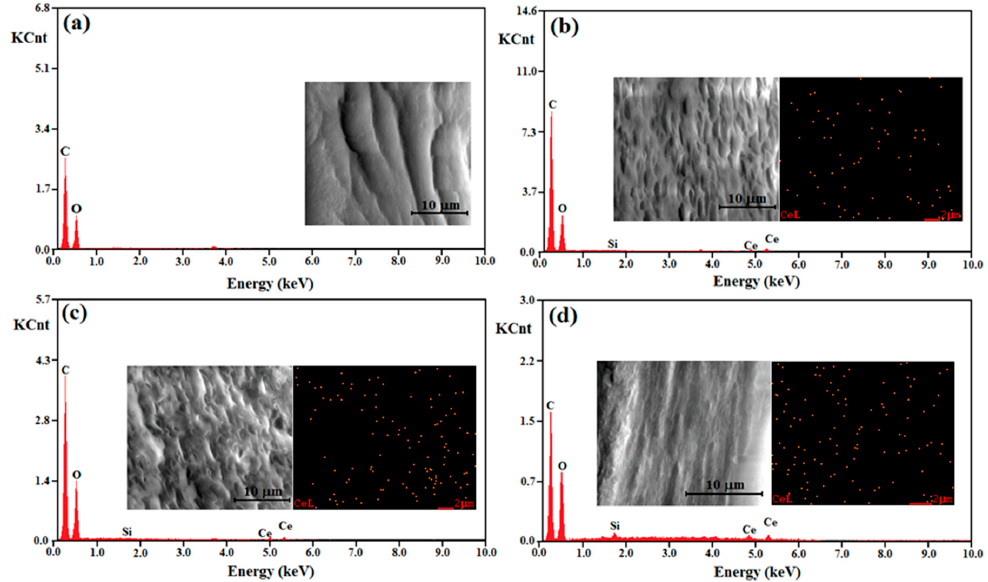
Figure 5. Energy-dispersive X-ray (EDX) spectra of cellulose acetate (CA) ( a ), CACe-1 ( b ), CACe-3 ( c ) and CACe-5 ( d ) films recorded in cross section. The inset shows SEM images and mappings of cerium in the film cross sections.